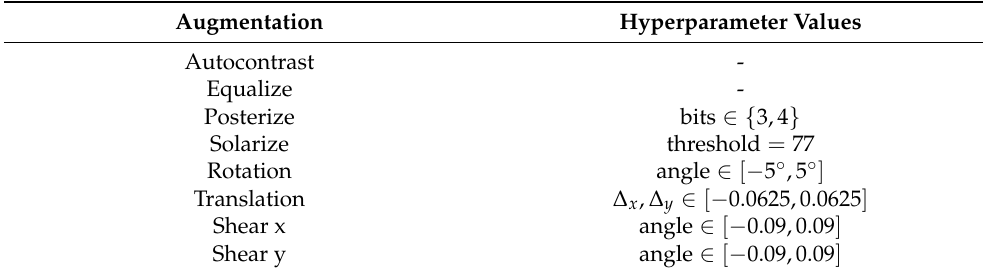
Table 3. Base augmentations and their parametrization range employed for